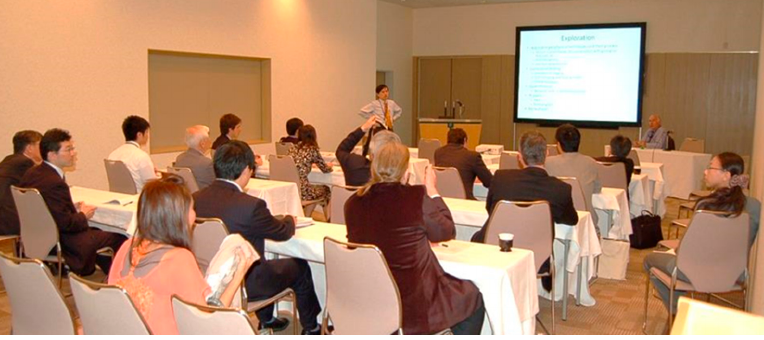
Figure 2. Scene from the breakout session (Methane Gas Hydrate Exploitation and Development) during the eighth Fiery Ice Workshop.